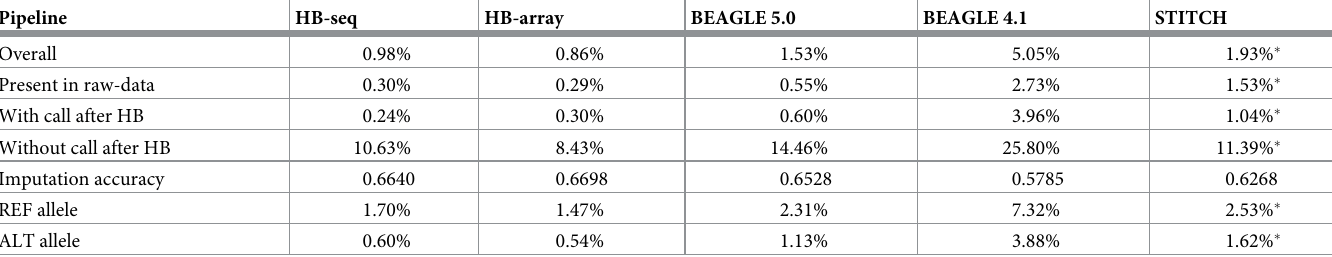
Table 2. Discordance rates between the imputed sequence data and high read-depth sequence data depending on the used imputation pipeline. � For cells with a genotype call in STITCH itself, discordance rates were only 0.59% compared to 0.78 / 0.68% for HB-seq / HB-array for the same entries. Pipeline HB-seq STITCH